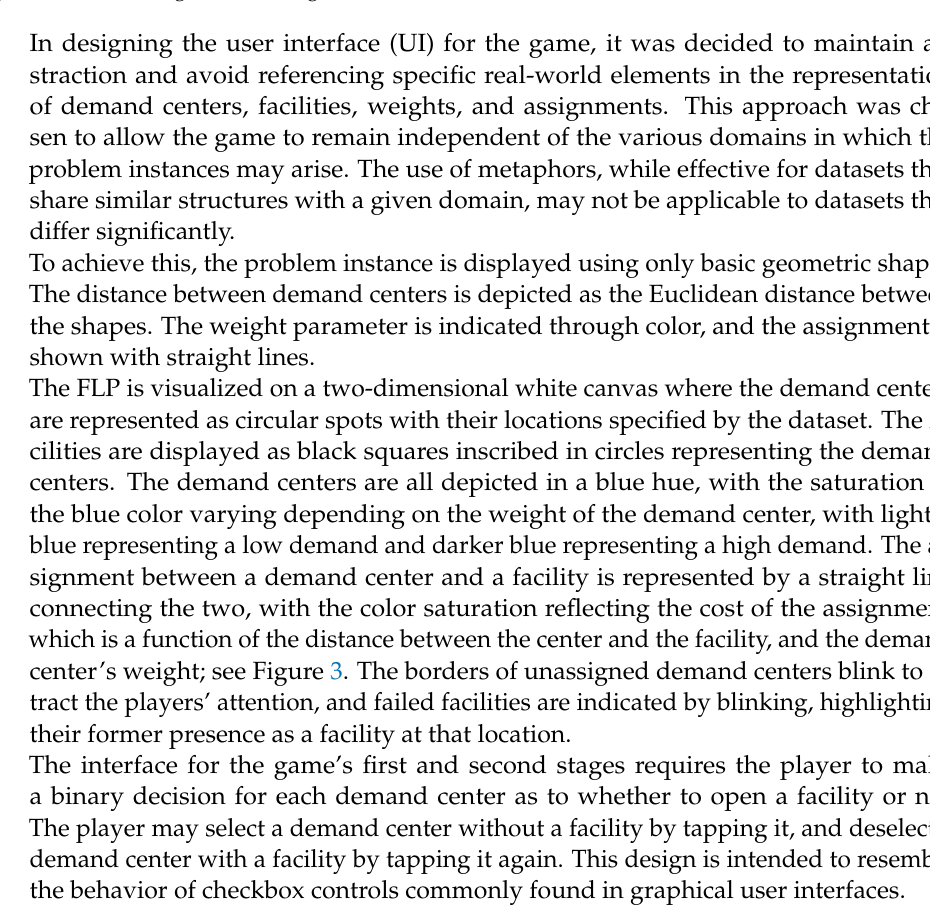
Figure 3. FLP video game showing the user